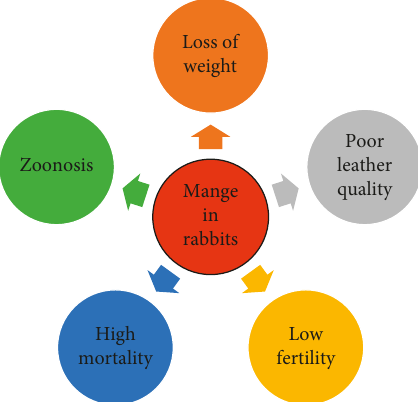
Figure 1: Economic losses in rabbit’s production system due to manage